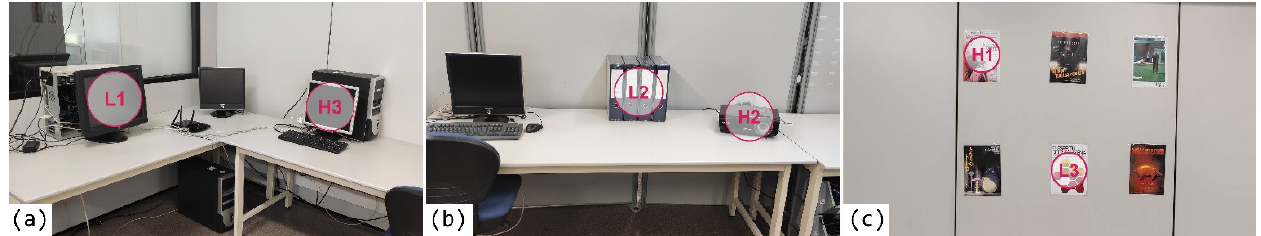
Figure 5. User testing the application ( a ) and screenshot of the application during the AR annotation search ( b ). Figure 6. AR annotations that users had to find during the experimental study.